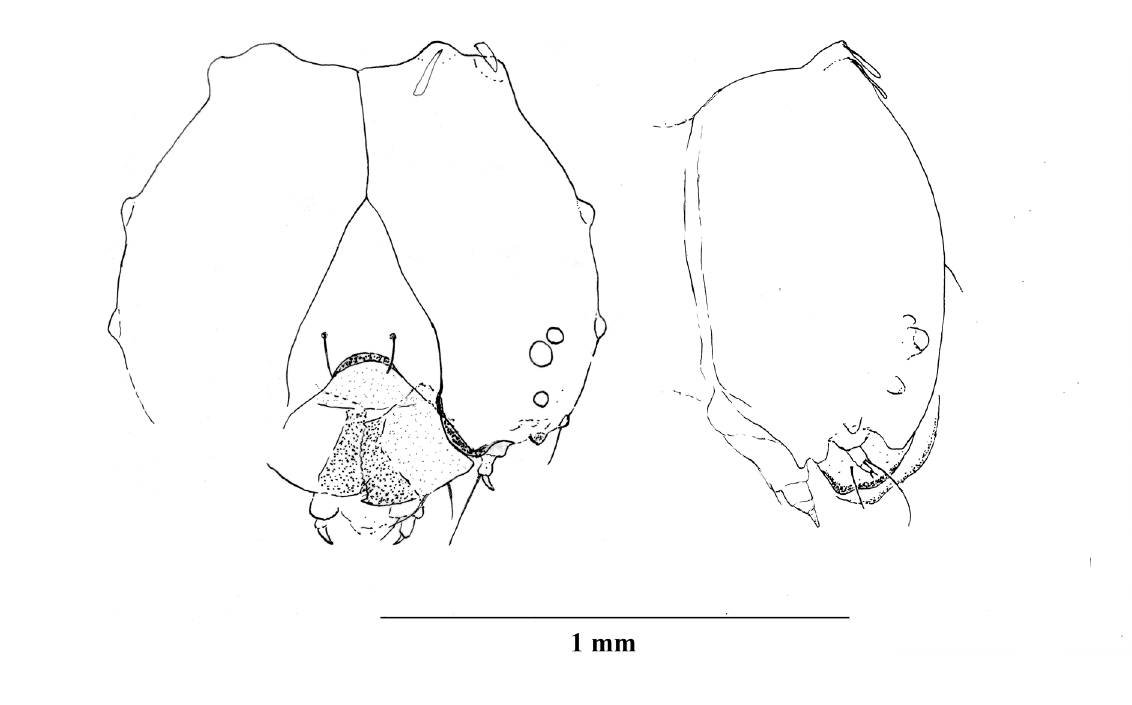
Fig. 9. Zischkaia arenisca Nakahara, Willmott & Hall, sp. nov., first instar head capsule in anterior and lateral